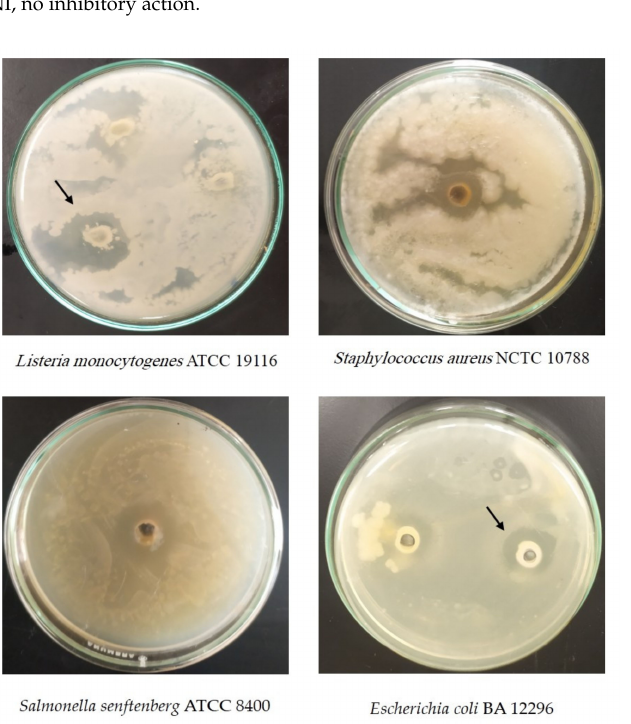
Figure 2. Antimicrobial activity of Cleome droserifolia (Forssk.) Del. extract against pathogenic